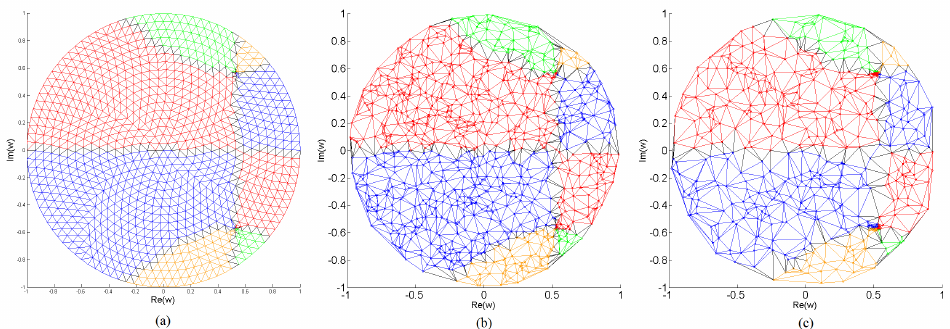
Figure 11. Distribution of nodes with Delaunay’s triangulation in final iteration for ( a ) the GRPF, ( b ) MGA-WPA and ( c ) MPSO-WPA methods. The stability tests of a fractional-order system are executed in the transformed region | w | < 1. Phase quadrants of mesh nodes on the w -plane: •Q = 1, •Q = 2,